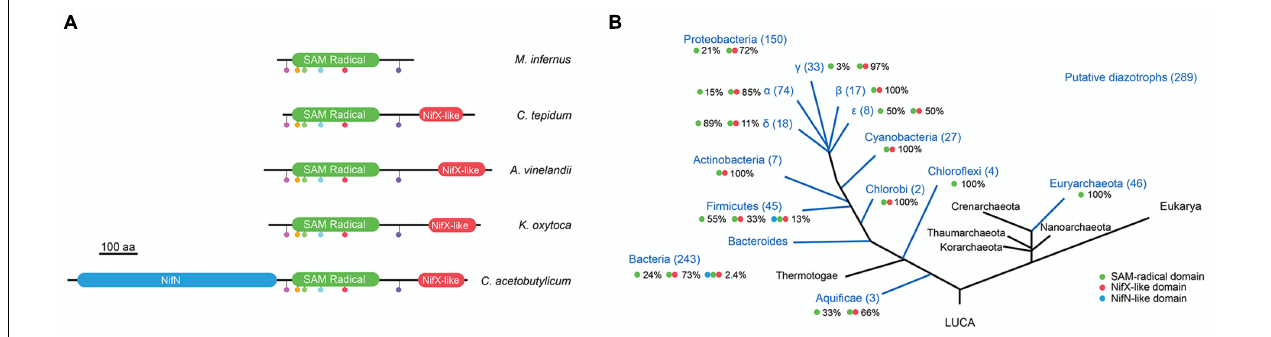
FIGURE 1 | Occurrence NifB architectures in diazotrophs. (A) Scheme of the three different NifB architectures and representative species known to possess them. The SAM-radical is shown in green, the NifX-like domain in red, and the NifN-like domain in blue. Color dots represent motifs strictly conserved in the SAM-radical domain. The scale bar represents 100 amino acids. (B) Overall distribution and relative frequency of NifB architectures in putative diazotrophs. Green dot represents the SAM-radical domain; red dot represents the NifX-like domain; blue dot represents the NifN-like domain. This panel was generated by overlapping data from Supplementary Table 1 with a 3-domain taxonomic tree of life modified from Boyd and Peters